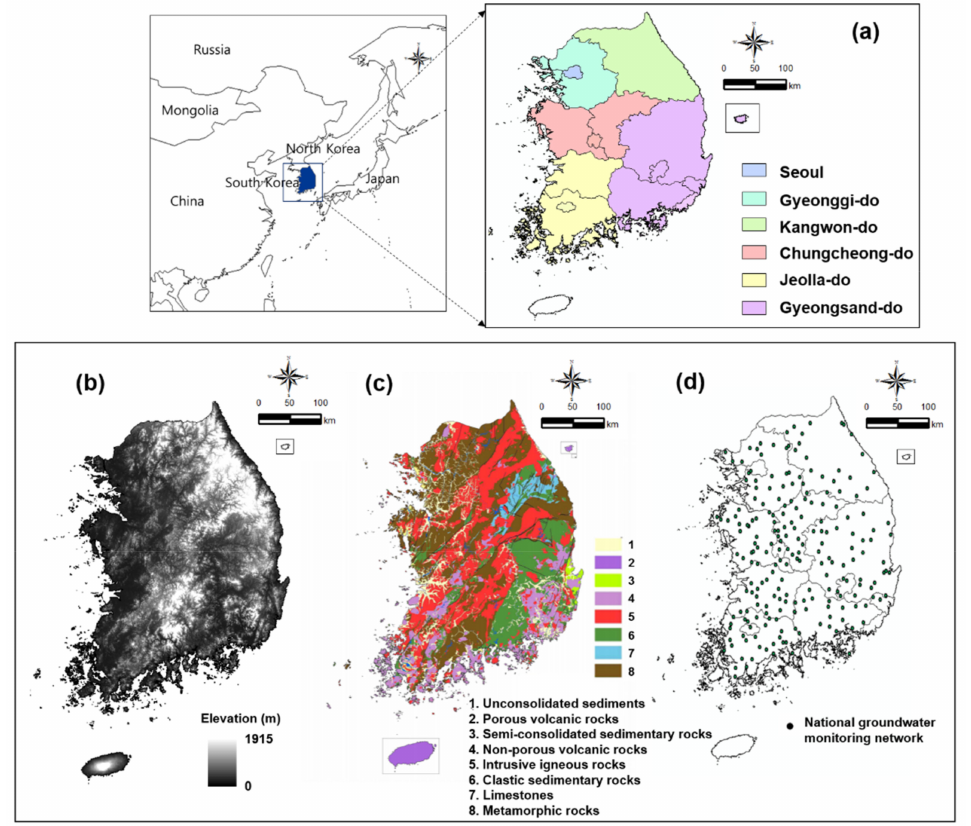
Figure 1. Locations of study area; ( a ) administrative district map; ( b ) digital elevation model (DEM); ( c ) geological map; ( d ) national groundwater monitoring